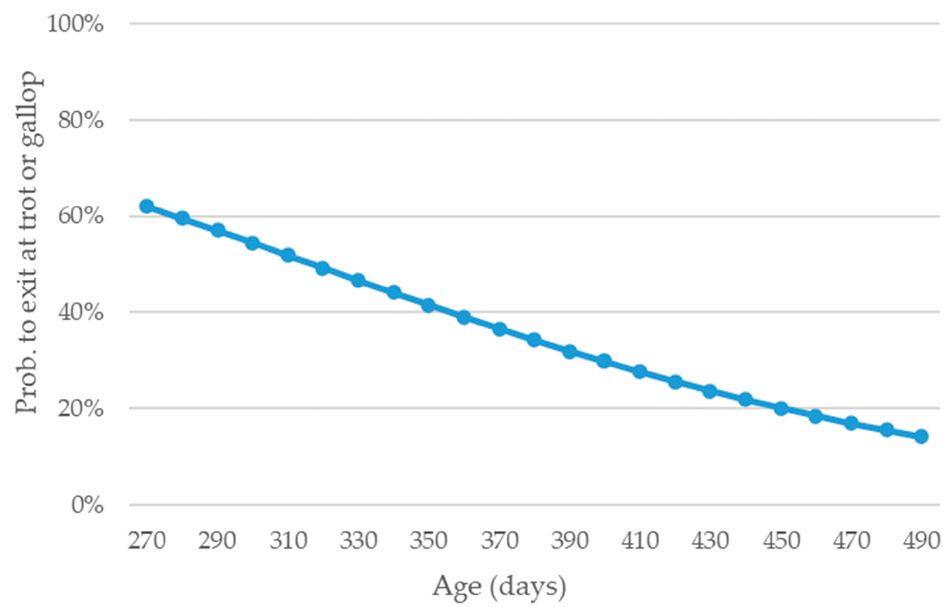
Scheme 1. Effect of age of Mertolenga young bulls on the probability to exit the chute at trot or